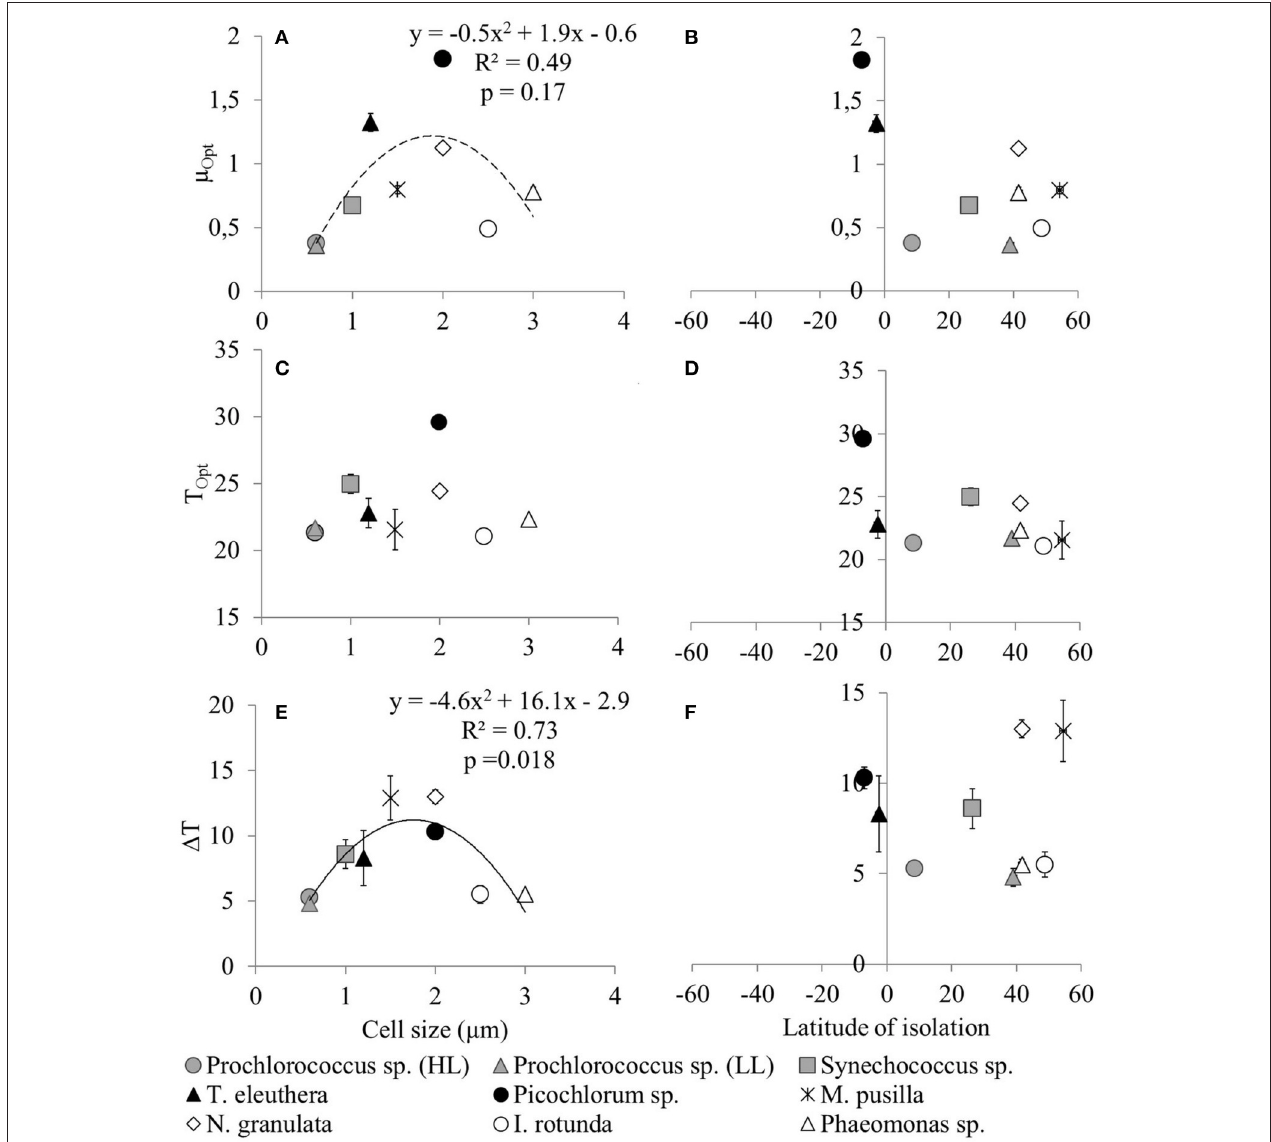
FIGURE 2 | Temperature-related parameters of individual picophytoplankton strains ( µ opt , T opt and 1 T) as a function of cell size (A,C,E) or latitude of isolation (B,D,F). The temperature-related parameters were obtained from an optimum fit (Equation 3) to the measured maximum growth rates of individual picophytoplankton strains for the representation of the response of maximum growth rates to temperature and are shown in Table 3 . Error bars are asymptotic standard errors. Lines indicate unimodal functions [continuous line: Significant, p = 0.018, r 2 = 0.728; dotted line: Not significant, p = 0.17, r 2 = 0.485, but included because a significant trend was found by Bec et al.